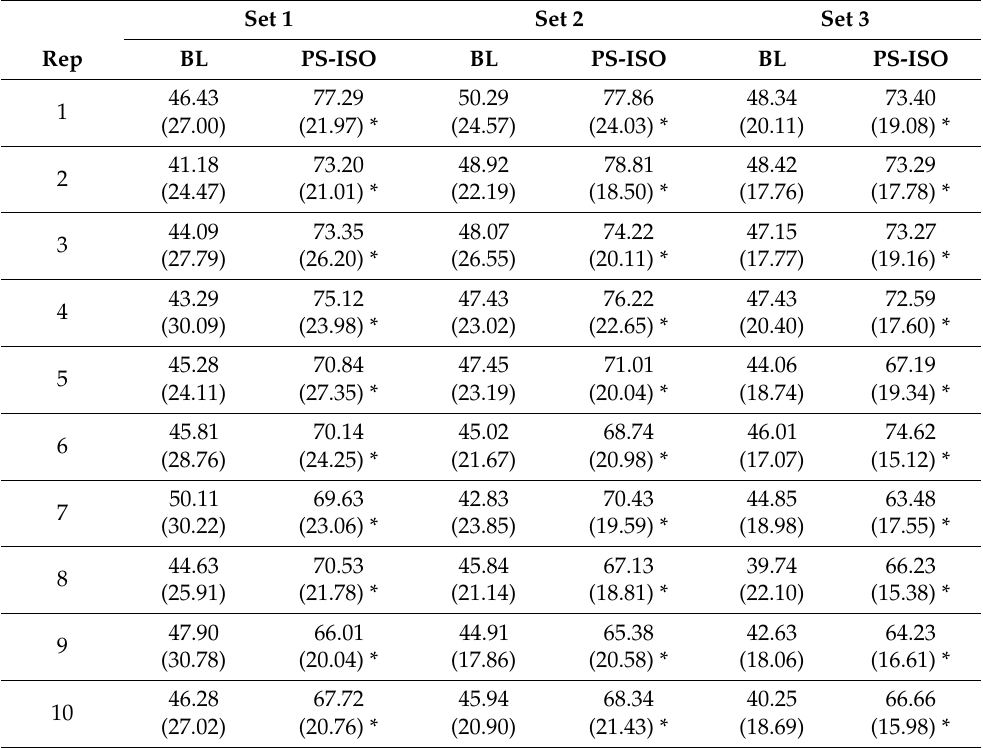
Table 1. Torque values (Nm) for baseline and PS-ISO contractions.